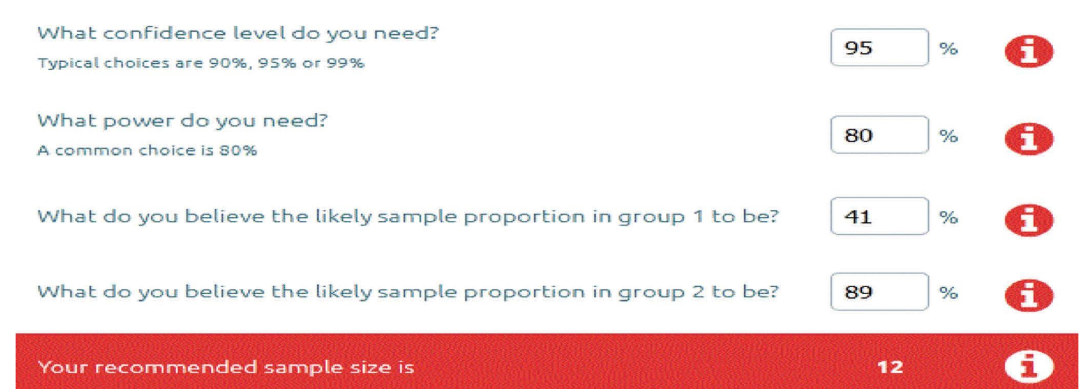
Figure 1: Sample size determination by power analysis and sample size